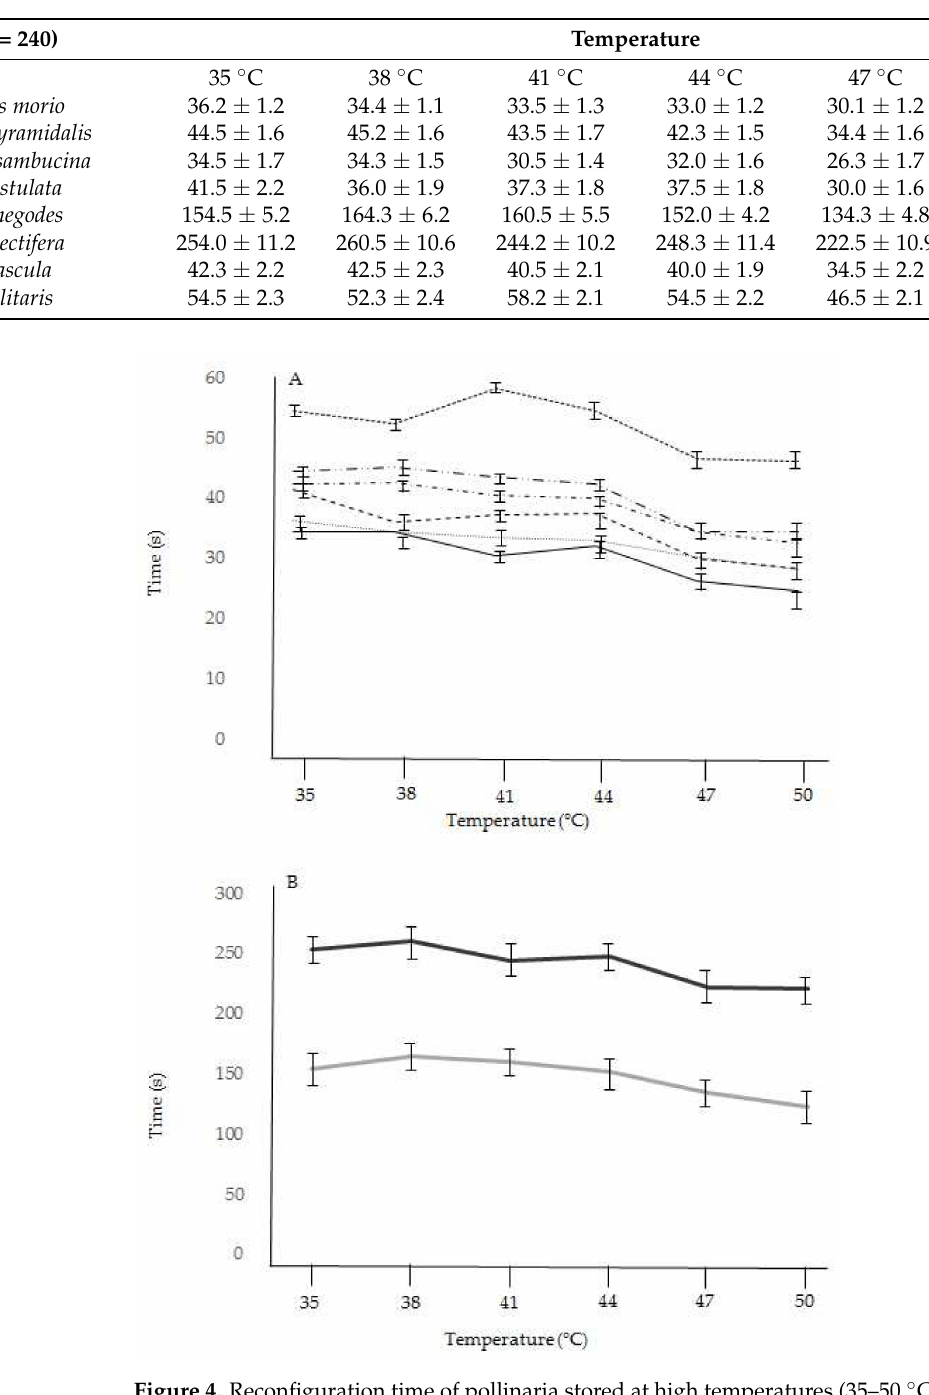
Figure 4. Reconfiguration time of pollinaria stored at high temperatures (35–50 ◦ C) of food-deceptive orchids ( A ) and sexually deceptive orchids ( B